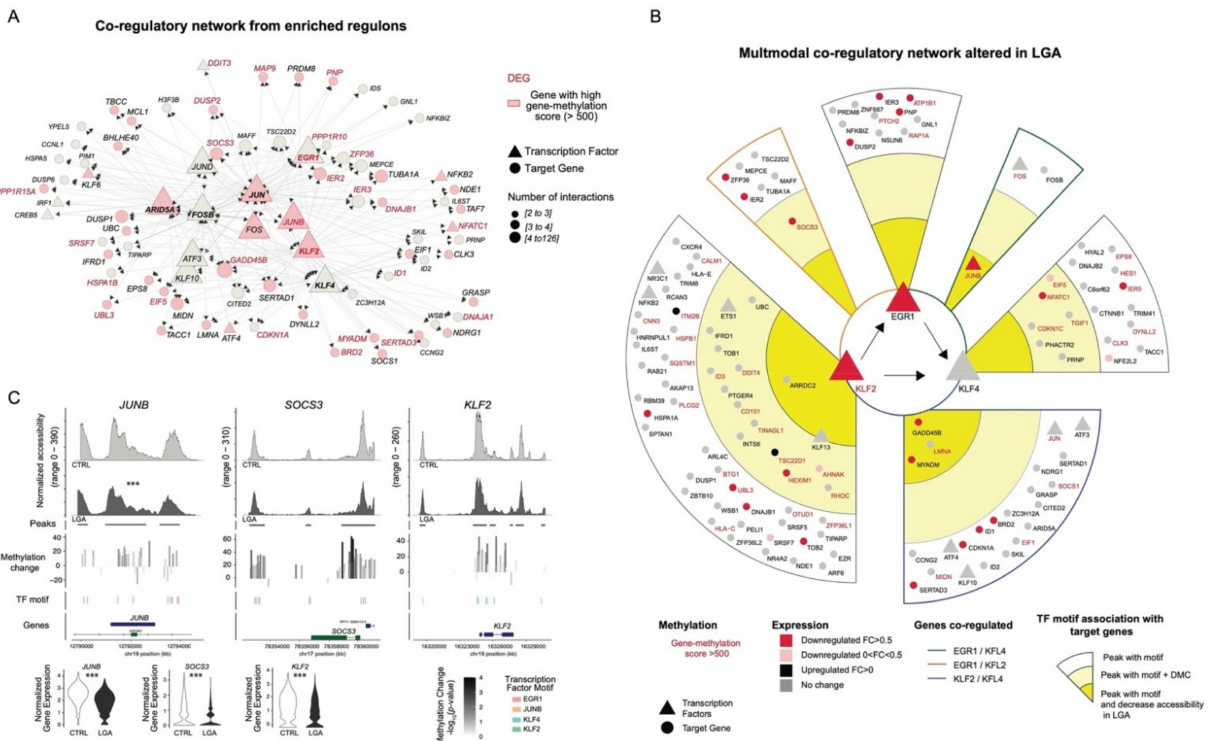
Figure 6. Network recapitulating interaction between the epigenomic and transcriptomic alter- ations in LGA. ( A ) Network representing interactions between target genes and transcription factors considering our top affected regulons ARID5A, EGR1, KLF2, KLF4, FOSB, and JUN. Each dot repre- sents a gene within the network, the triangle represents a transcription factor, the arrow represents the interaction between the transcription factor and target genes, shapes are color-coded to reflect the change in gene-methylation score, and DEGs are labeled in red. Size of the shape represents the number of interactions. Only genes with two or more interactions are represented. ( B ) Tracks representing DNA methylation and chromatin accessibility for selected representative regions. His- togram representing change in DNA methylation at CpG level comparing LGA vs CTRL. Violin plot representing gene expression for selected genes ( C ) Network-based on the integration of DNA methylation, gene expression, and chromatin accessibility representing transcription factors and downstream target interactions within EGR1, KLF2, and KLF4 regulons. Only genes associated with peaks with TF motifs of interest are annotated. Donuts represent different levels of interactions. ***: significant change of peak accessibility (logistic regression) or gene expression (Wilcoxon test) in LGA compared to Control HSCs, adjusted p -value <